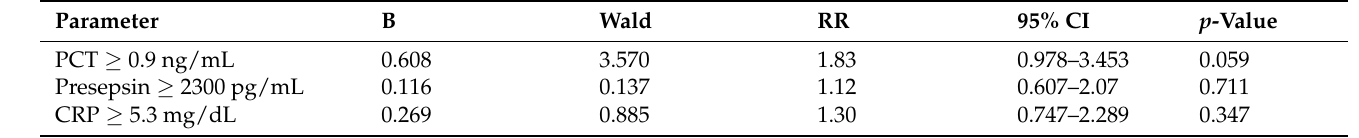
Table 3. Cox regression model for in-hospital